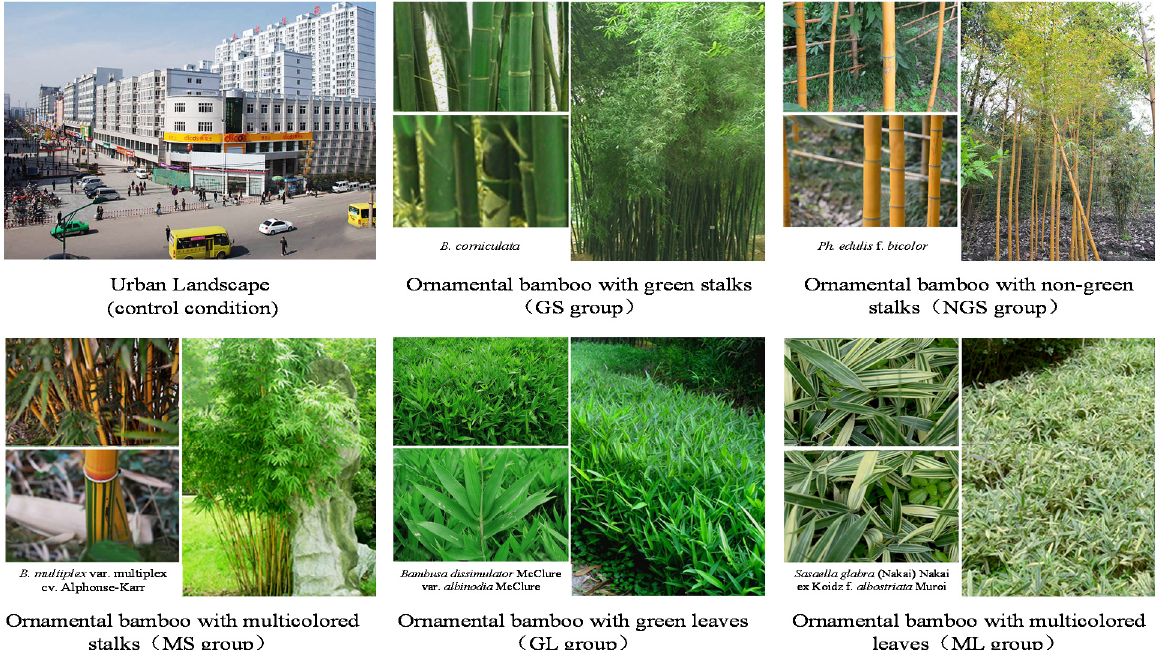
Figure 1. Stimulus images. GS group: ornamental bamboo with only green stalks; NGS group: ornamental bamboo with only non-green stalks (e.g., yellow, white, purple); MS: the stalks of ornamental bamboo appear in two or more colors; GL: ornamental bamboo with only green leaves; ML: the leaves of ornamental bamboo appear in two or more colors.